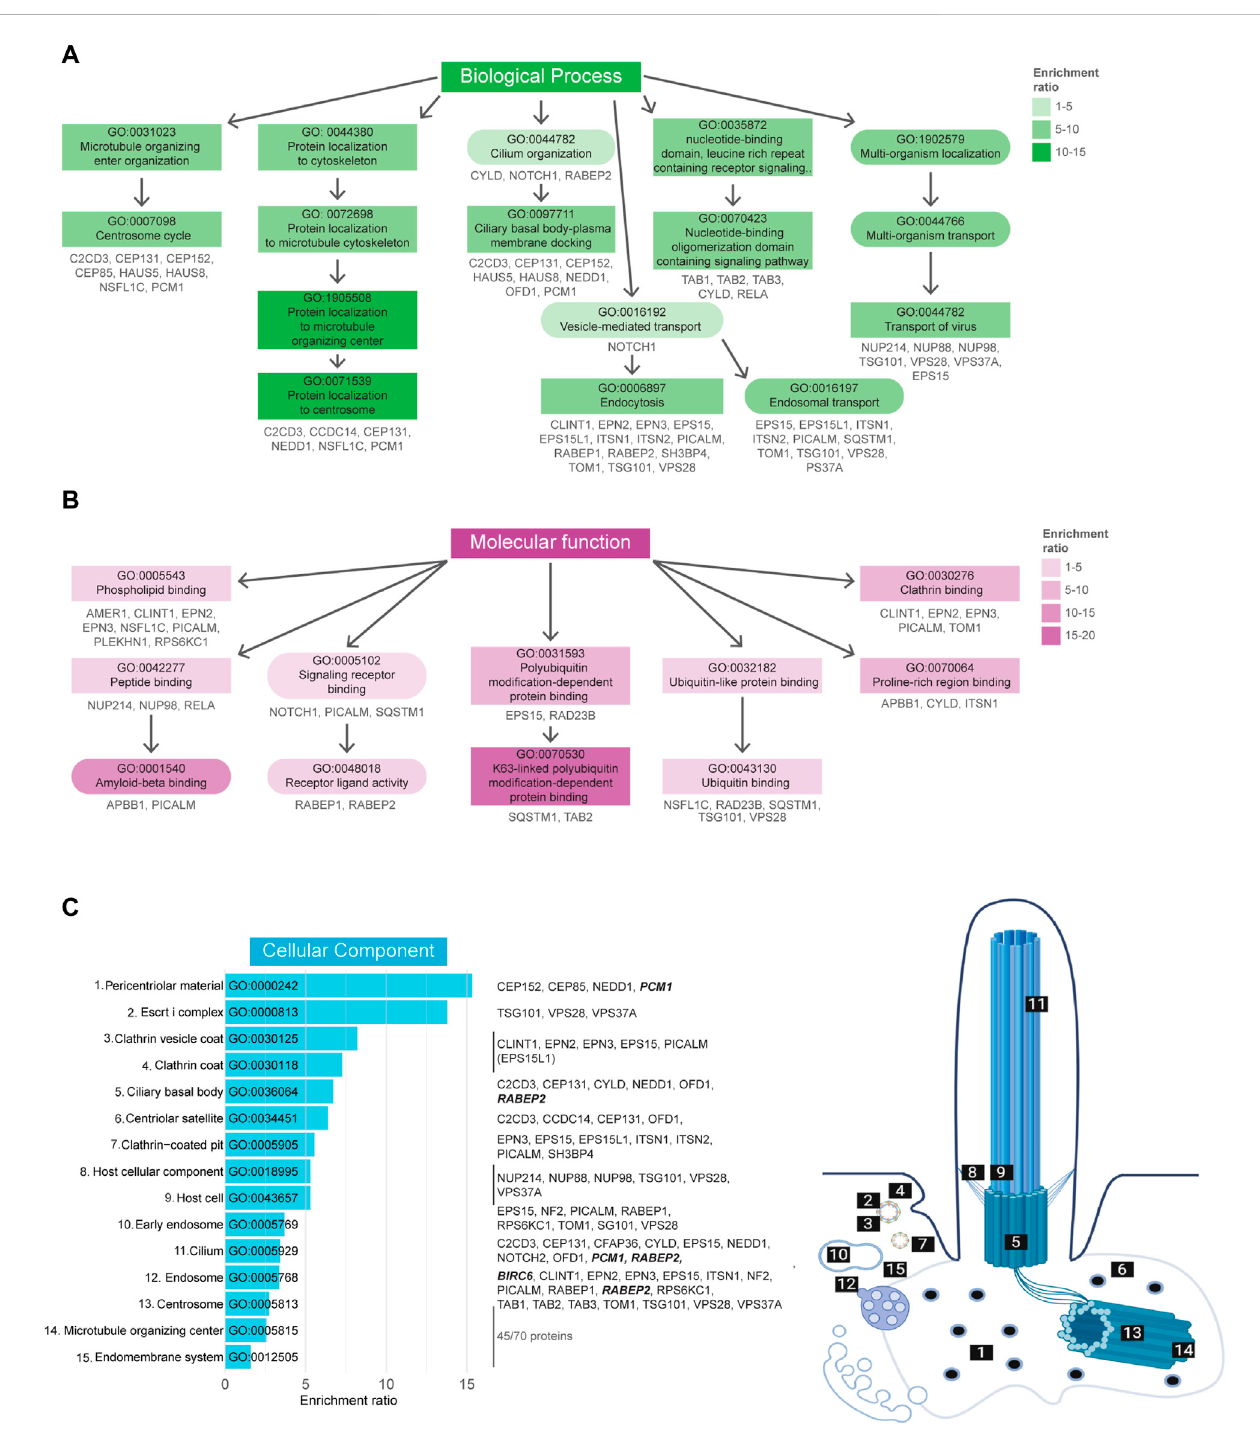
GeneOntologyenrichmentanalysisofUBDdataset. (A) GOtermenrichmentforbiologicalprocesses(BP)coloredbytheirenrichmentratio.The11most enriched BPterms(Fisher ’ sexact testvalue ≤ 9.5E-5) are displayed (square) along with supportingGO terms(circle). Arrows indicate the related termsand the genes per term are indicated in grey. All upstream terms also include the genes from their downstream terms. (B) GO term enrichment analysis for molecular functions(MF)ofwhichthe8mostenrichedterms(Fisher ’ sexacttestvalue ≤ 5.5E-3)aredisplayedasin (B) . (C) The15mostenrichedterms(Fisher ’ sexact test value ≤ 7.5E-4) of the cellular components (CC) GO term enrichment analysis are displayed, ordered by their enrichment ratio. The cellular position of these terms and their related proteins are indicated on the right. The terms “ Host cellular component ” and “ Host cell ” do not directly refer to a ciliary localization, while their related proteins do (dashed line). The proteinsrelated to theterms ‘ Microtubule organizing center ’ and ‘ Endomembranesystem ’ were notindicated,asthereweretoomanytoclearlydisplay,howeveracompletelistofproteinscanbefoundinSupplementaryTableS1.Proteinsindicatedinbold italic letters were shared hits between UBD-PL and